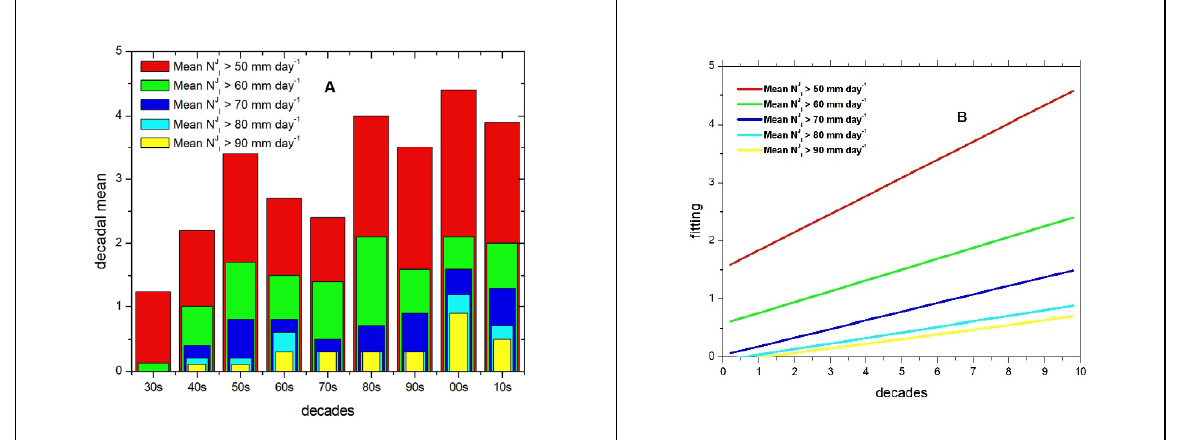
Figure 1. ( A ) Decadal average of days with precipitation higher than five thresholds. ( B ) Linear fitting for the decadal average. Colors in the bars and lines are related to the thresholds shown in the legend.